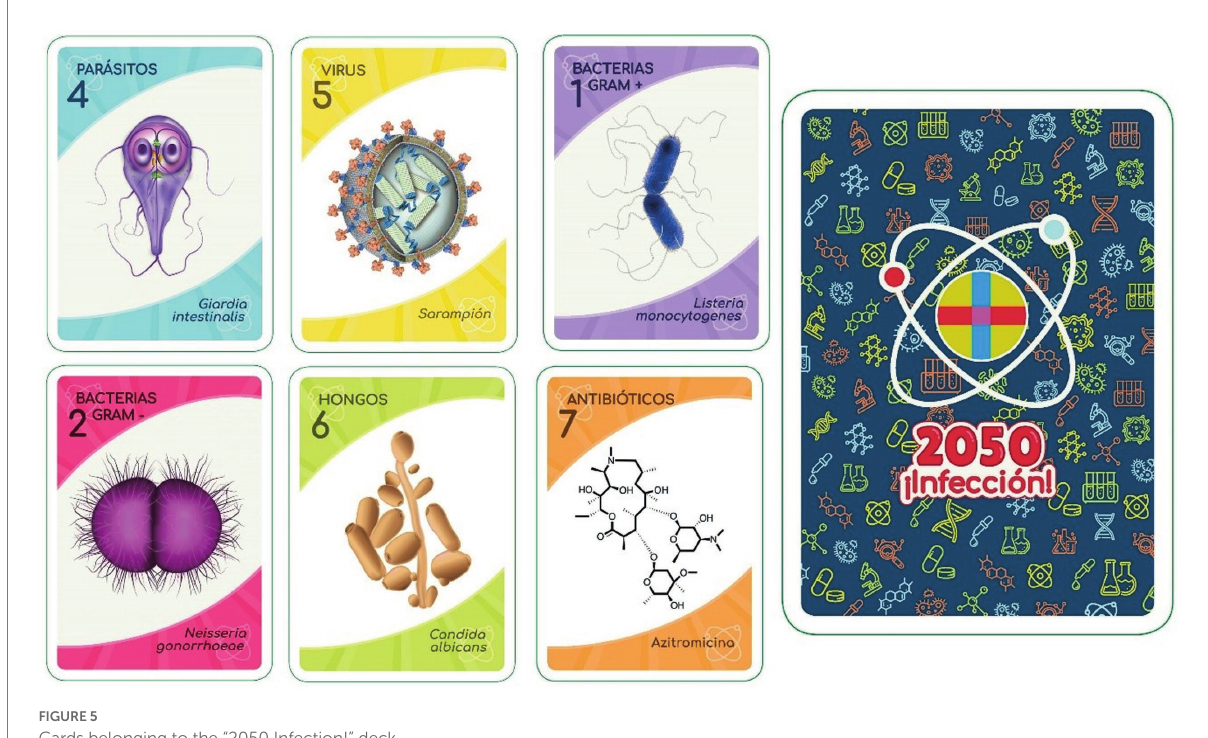
FIGURE 5 Cards belonging to the “2050 Infection!”